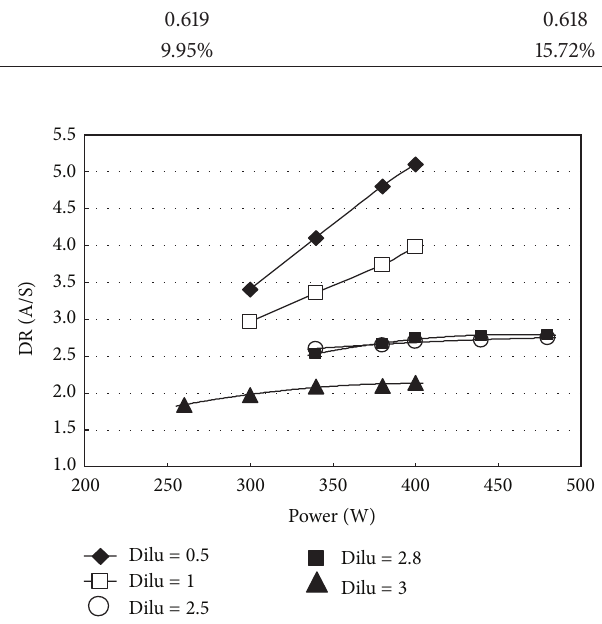
Figure 1: Deposition rate of the amorphous silicon intrinsic layer as a function of Dilu and Pw. FR and 𝑃 are kept at 20.8 slm and 0.5 mbar,